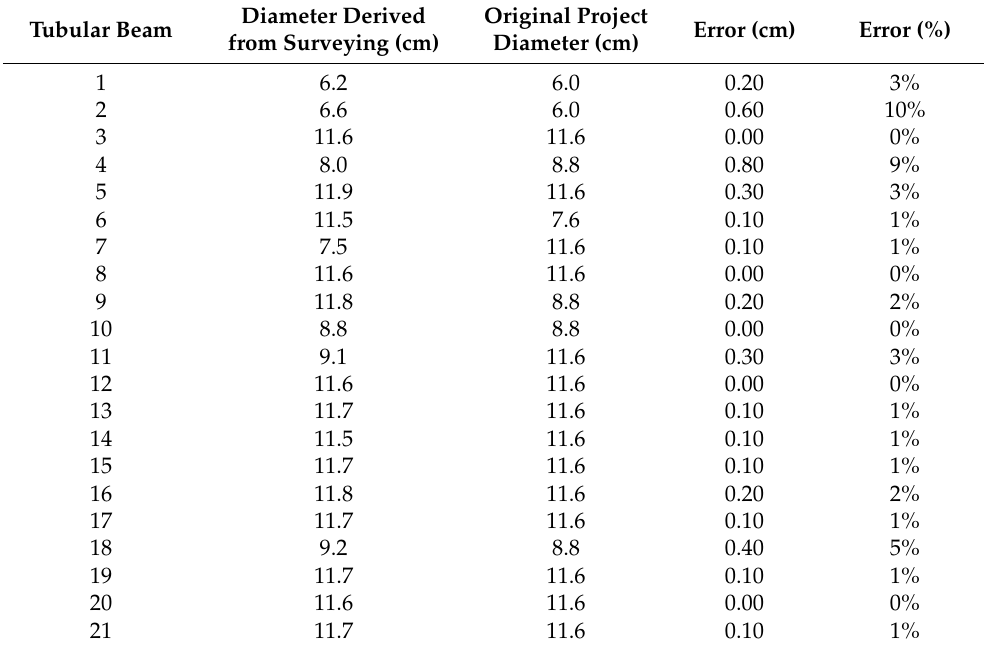
Table A1. Reconstruction error analysis of the tubular beams of the first mesh in terms of size (cm) and percentages.